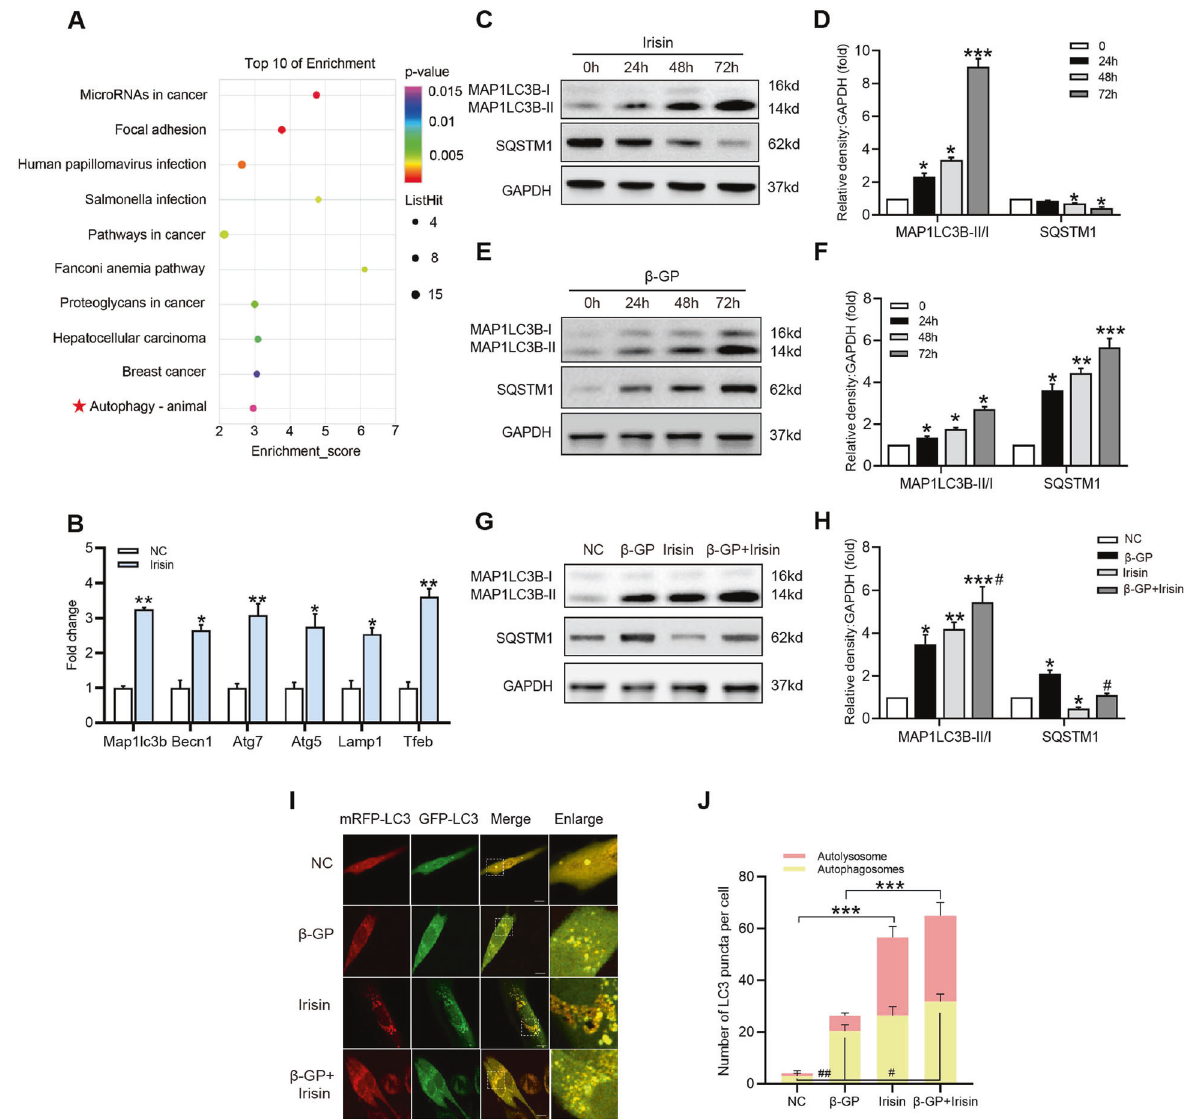
y-axis represents the enriched pathways. The color of the bubble represents the P value of the pathway enrichment. The size of each bubble represents the number of different genes contained in the pathway. B VSMCs were treated with Irisin (100 ng/ml) for 72 h and the mRNA level of Map1lc3b , Becn1 , Atg7 , Atg5 , Lamp1 , and Tfeb was assessed by qRT-PCR. Data are expressed as mean ± SEM. *P < 0.05, **P < 0.01 vs. control group. C – F VSMCs were treated with Irisin (100 ng/ml) or β -GP (10 mM) for the indicated time. Protein levels of MAP1LC3B and SQSTM1were determined by western blotting. G, H VSMCs were incubated with or without Irisin (100 ng/ml) in the presence of β -GP (10 mM) for 72 h. Protein levels of MAP1LC3B and SQSTM1 were evaluated by western blotting. Data are expressed as mean ± SEM. *P < 0.05, **P < 0.01, ***P < 0.001 vs corresponding control group; # P < 0.05, ## P < 0.01 vs corresponding β -GP group. I Confocal microscopy observation of mRFP-GFP-LC3 adenovirus transfected VSMCs treated as indicated (Magni fi cation: ×63, Scale bars = 10 μ m). J Autophagosome (yellow dots) and autolysosome (red dots) numbers in each group were calculated. Data are expressed as mean ± SEM. *P < 0.05, **P < 0.01, ***P < 0.001 vs. indicated group; # P < 0.05, ## P < 0.01 vs. indicated